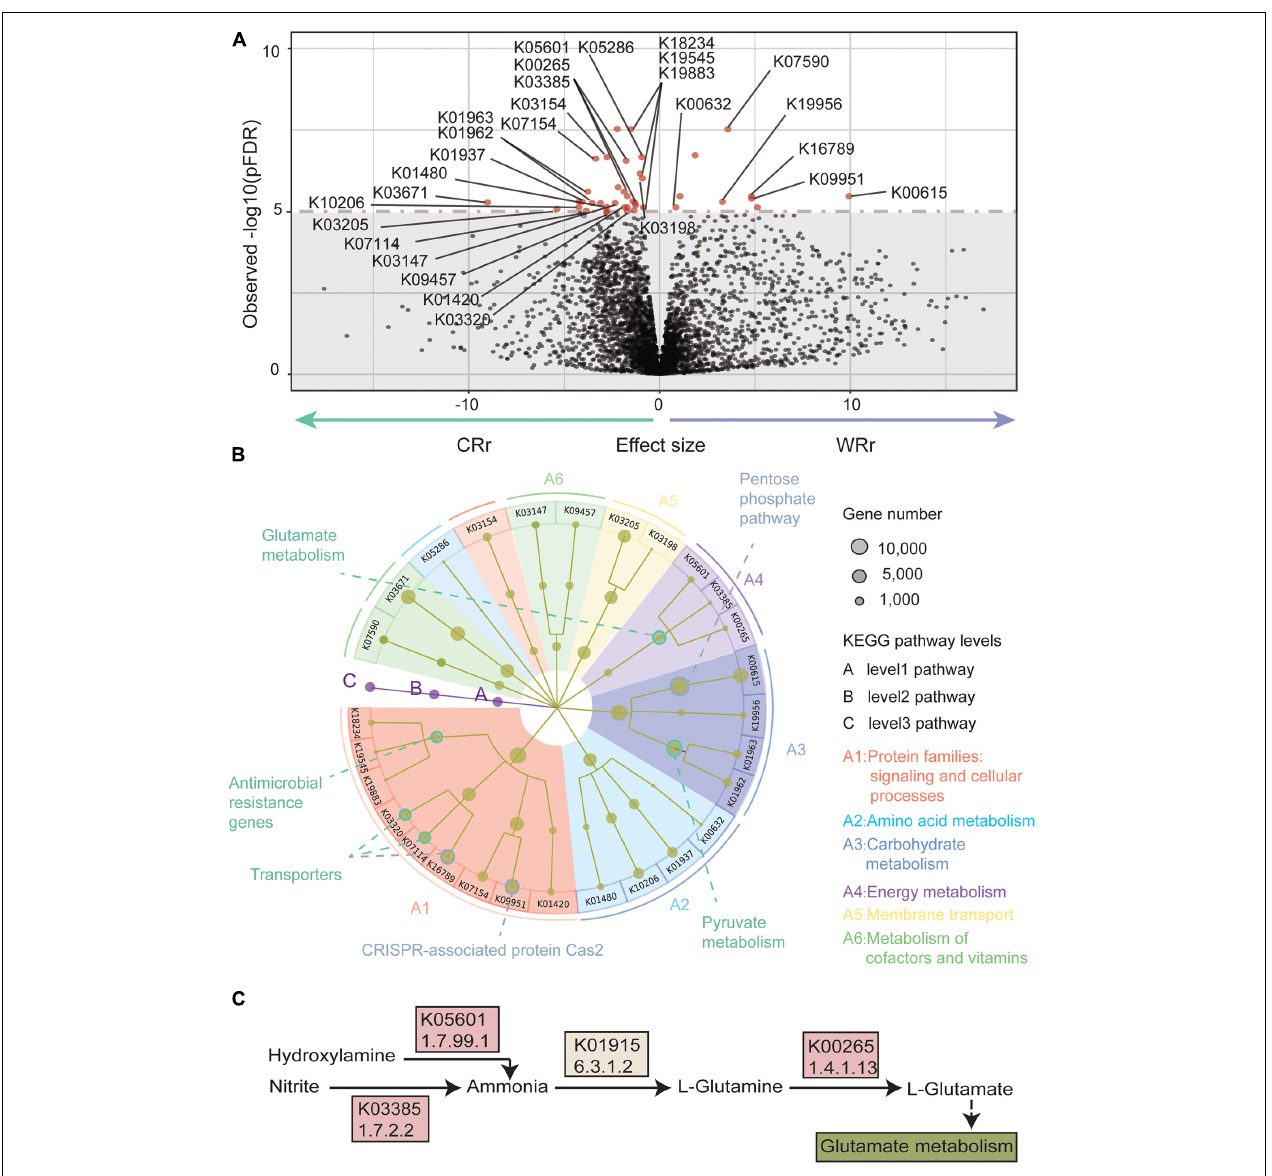
FIGURE 3 | Metagenome-wide association study results of the wild-captive R. roxellana gene association test. (A) A volcano plot of the K-numbers based on the KEGG database. In the volcano plot, the x -axis indicates beta value of the GLM as the effect size. The y -axis indicates observed –log10 [ p(FDR) -values]. The horizontal dotted line indicates p(FDR) = 1e-5. There were 40 K-numbers with p(FDR) < 1e-5 are plotted as red dots, and other clades are plotted as black dots. (B) System diagram of KEGG pathways enriched with the 40 K-numbers highlighted in (A) . The three levels are defined as A, B, and C and described from the inner layer out. The size of the dots represents the number of genes. The eight pathways with significant enrichment are outlined by circles (green: pathways with significantly different abundance in CRr samples; gray: pathways with significantly different abundance in WRr samples). (C) A pathway diagram showing the K-numbers associated with glutamate metabolism. Panel (A–C) show the significantly differentially abundant pathways between captive and wild R. roxellana and the abundance K-numbers associated with L-glutamate in the captive